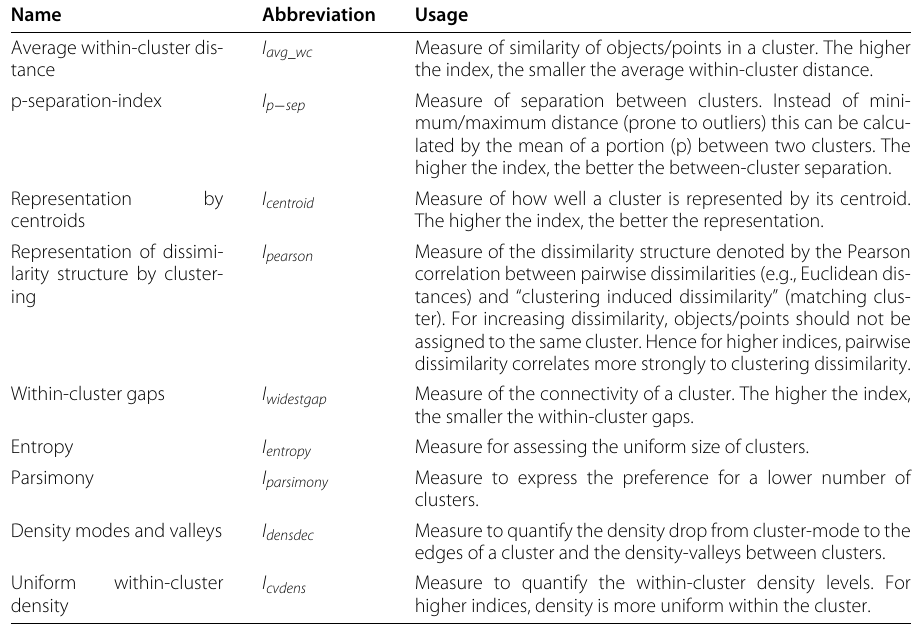
Table 1 List of cluster validation indices used in this work